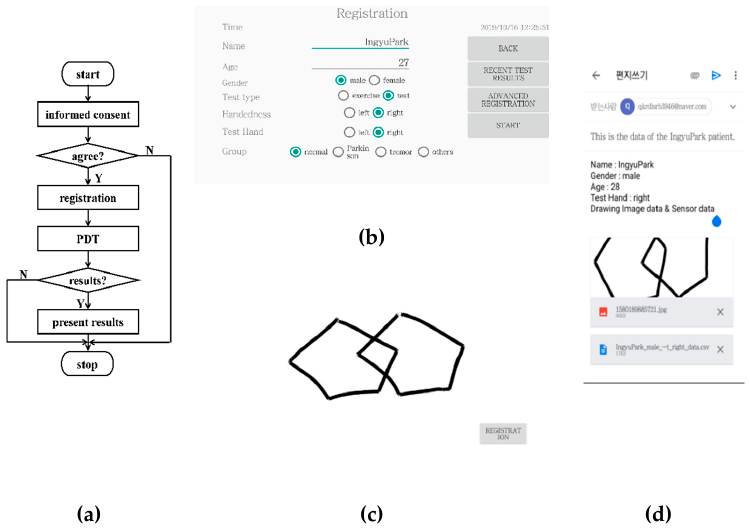
Figure 1. ( a ) Flow diagram of the mobile phone pentagon drawing test (PDT) (mPDT) operation; screen shots of the ( b ) registration window; ( c ) PDT window; and ( d ) results window of the mPDT.